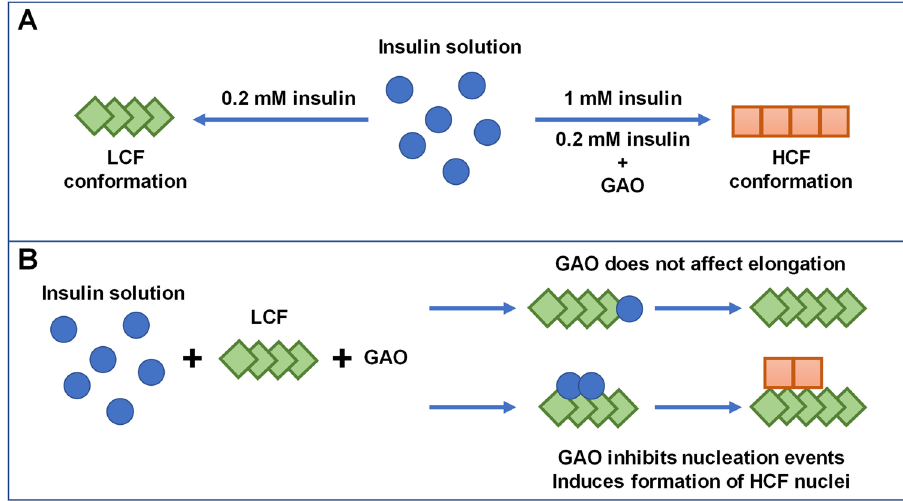
Figure 6. Formation of distinct insulin fibril conformations based on protein concentration and the absence or presence of GAO ( A ). Effect of GAO on LCF elongation, as well as nucleation